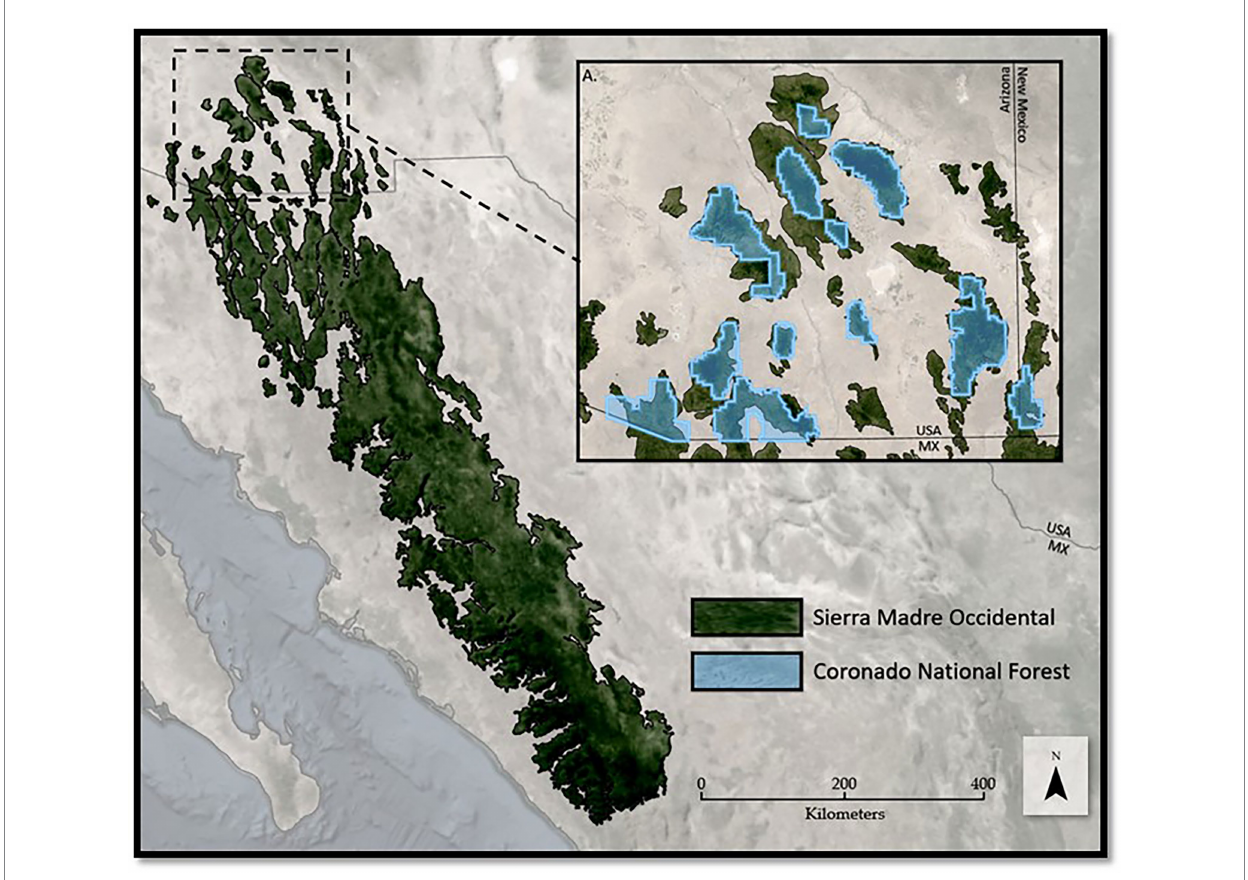
FIGURE 1 The spatial extent of (A) the Sierra Madre Occidental (SMO) symbolized in dark green and, (B) the Coronado National Forest boundary in light blue